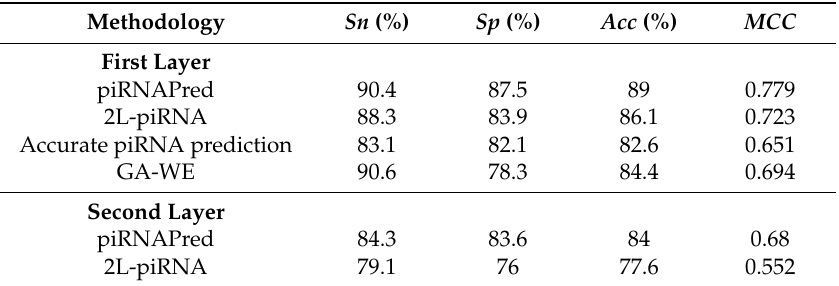
Table 4. The best prediction achieved by single type of features for the first